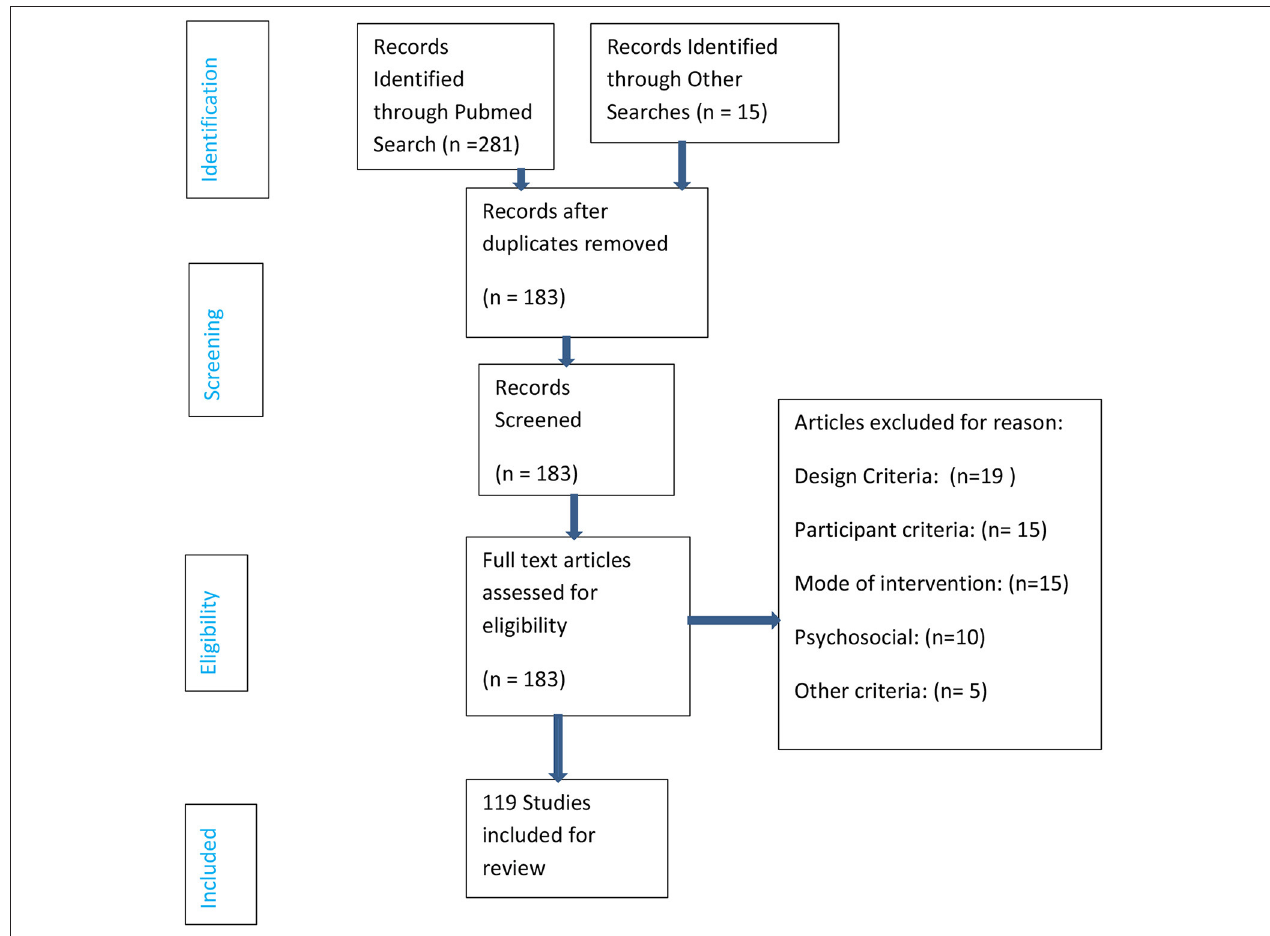
FIGURE 1 | Decision tree for method of articles selection for